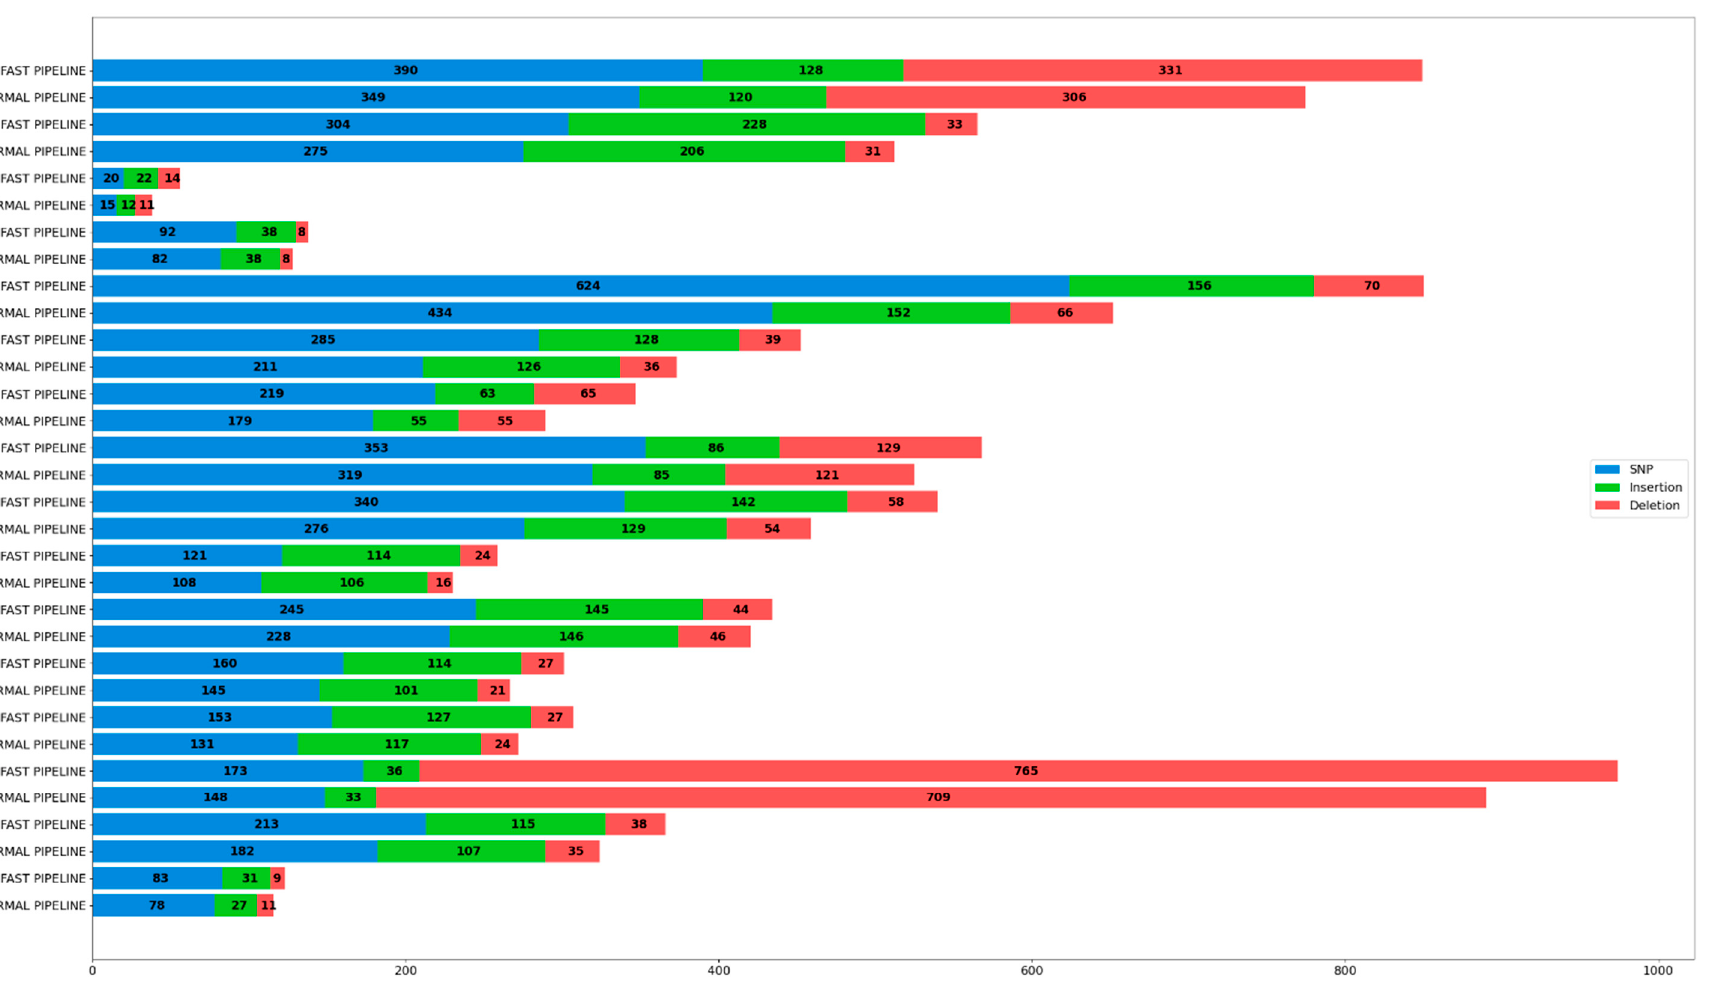
Figure 3. Variation (SNP, Insertion, and Deletion) Detected in All Samples Implemented in Both Pipelines.